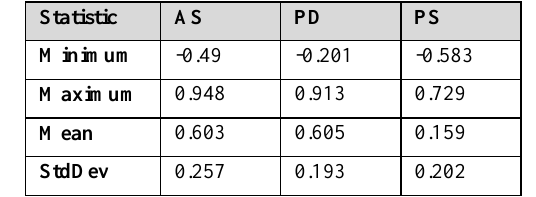
Table 5. NDVI reflectance values obtained from each dataset